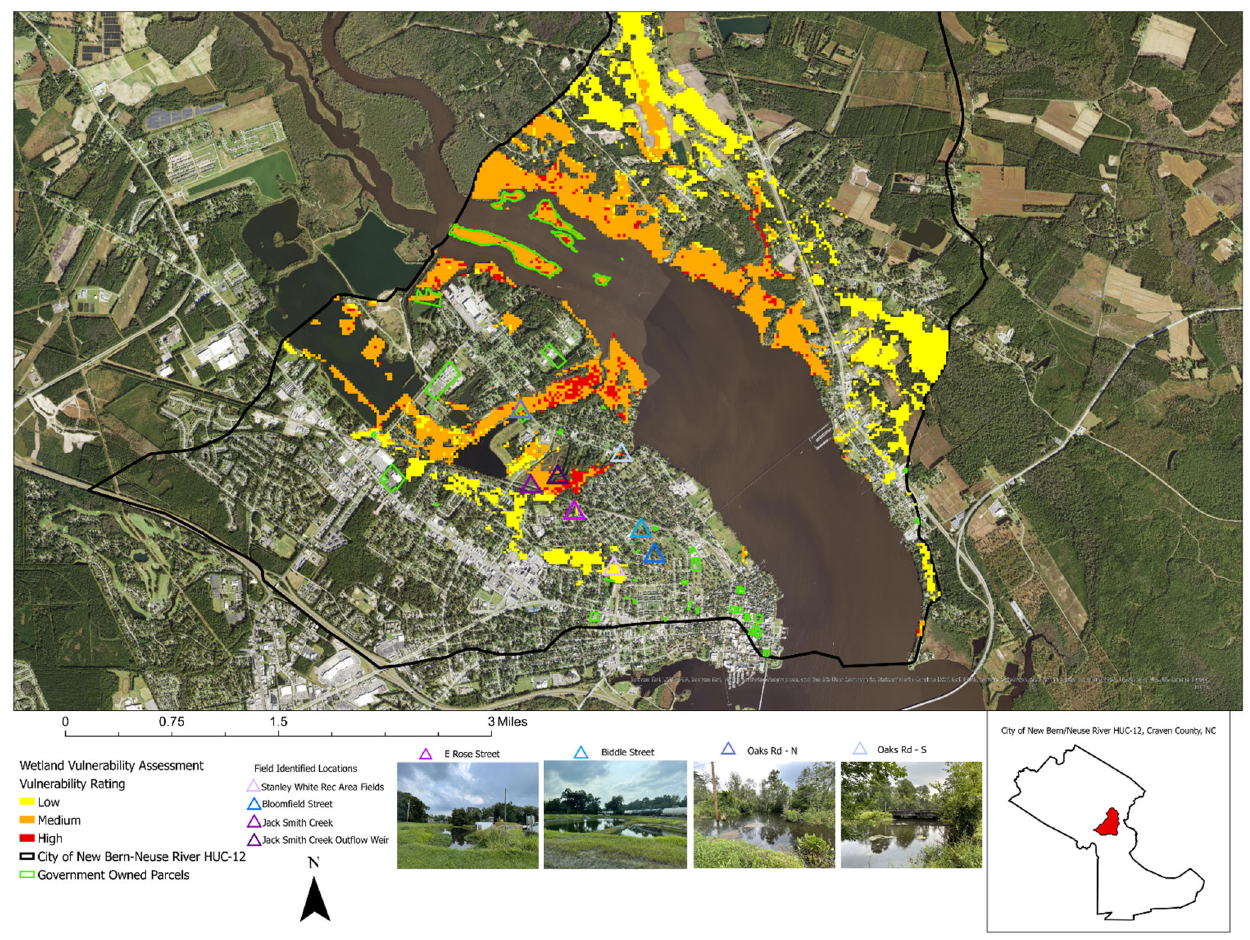
Figure 7. Wetland vulnerability assessment results, government ‐ owned parcels, and locations identified in the field as potential NBS sites in the Trent River subwatershed in New Bern, NC overlaid on NAIP imagery. Table 5. Highest vulnerability parcels in the Smith Creek subwatershed, Masonboro Island–Mason Inlet, Neuse subwatershed, and the Trent River